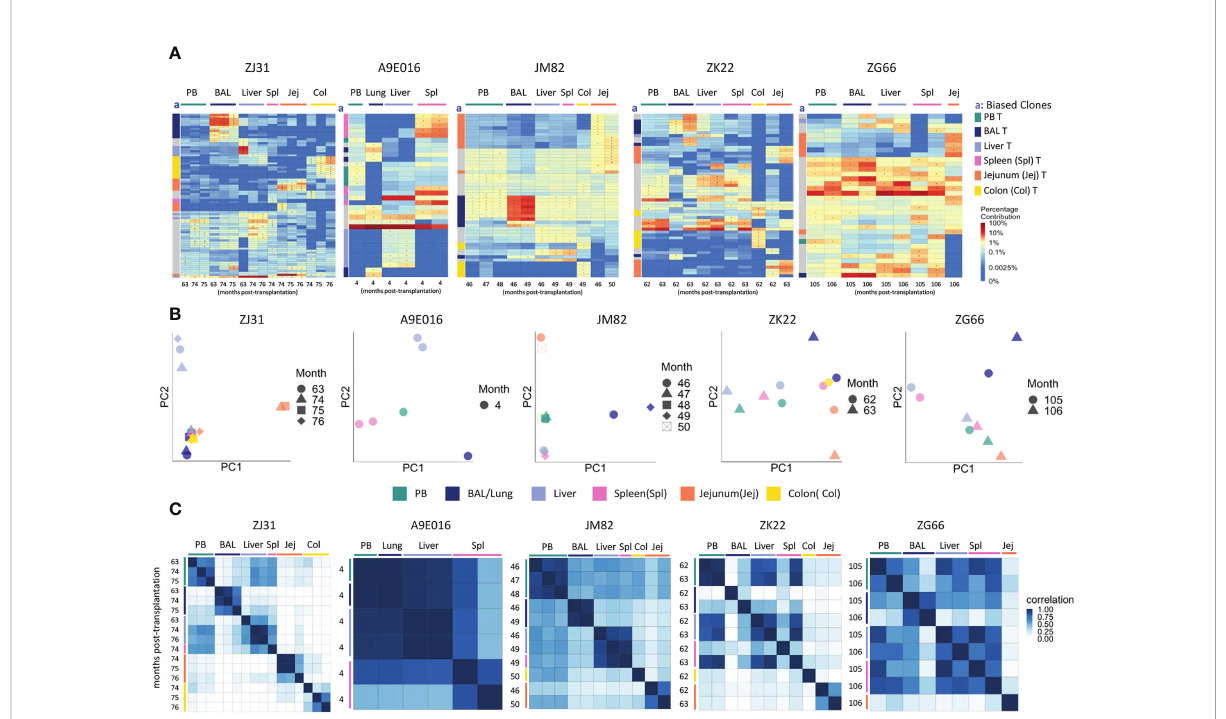
FIGURE 2 T cell clonality analyses in blood and tissues (A) Heat maps of the natural log fractional abundance of the highest contributing clones de fi ned as all barcodes present as a top 10 highest contributing barcode in at least one of the T cell samples puri fi ed from PB or tissues, mapped over all samples for each animal (A9E016, JM82, ZK22, ZJ31 and ZG66). Each row corresponds to one unique barcode; * indicates the barcode is one of the top 10 for that sample. Each column corresponds to a tissue source and time point in months post-transplantation as labeled. Heat maps are organized by unsupervised hierarchical clustering of Euclidean distances between barcode ’ s log fractional abundances, with relative contributions for each clone speci fi ed per the color gradient shown on the far right. The column labeled “ a ” on the far left of each